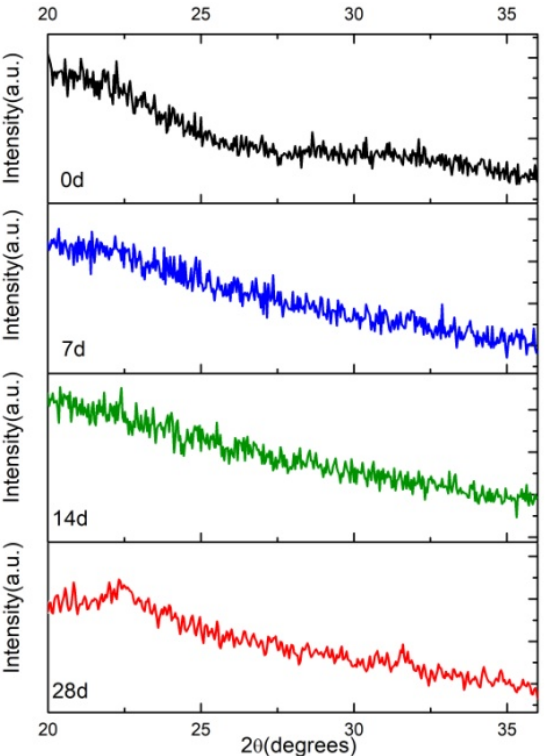
Figure 8. XRD analysis of the coated polymeric scaffold at different time of soaking in SBF: 0 (0D), 3 (3D), 14 (14D) and 28 days (28D).